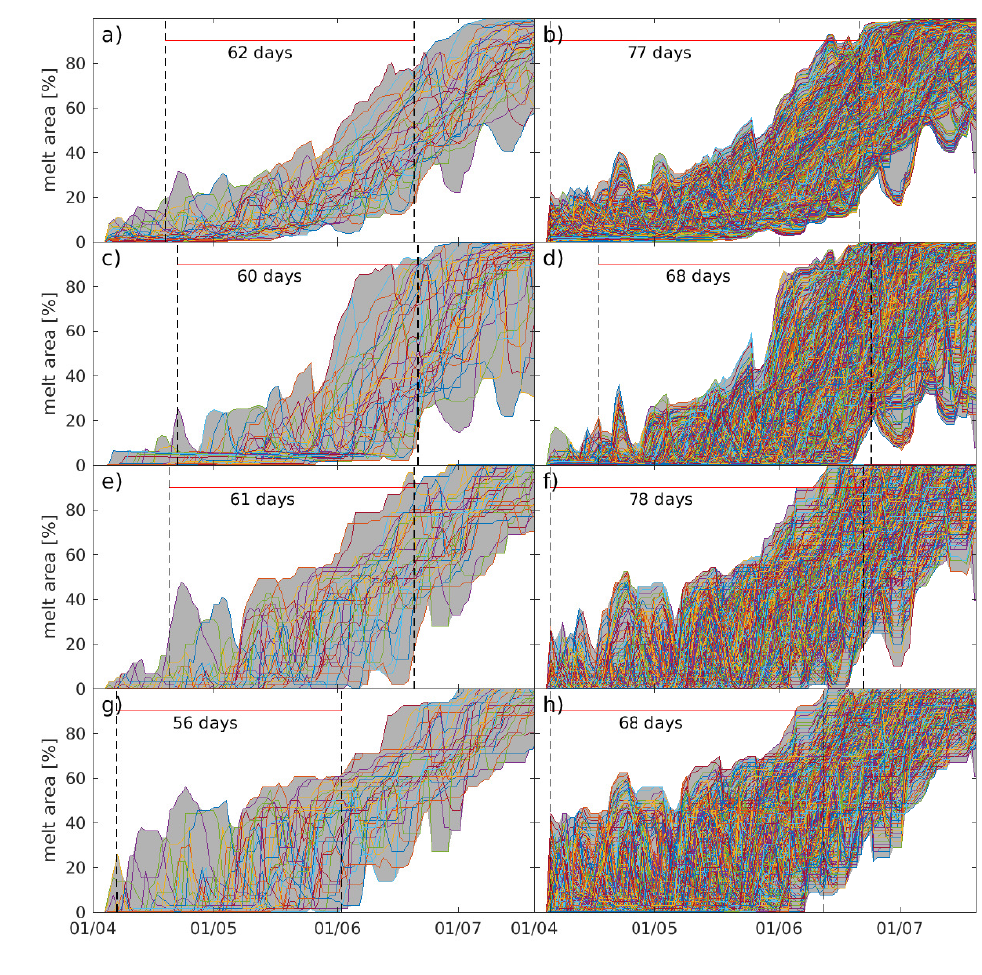
Figure 9. Time series of melt area for ( a , b ) Vatnajökull; ( c , d ) Brúarjökul; ( e , f ) Skaftá GWC; ( g , h ) Síðujökull. The four left figures show the melt area when the spring conditions are held constant, using the conditions from April 2000. The right figures show all the simulated runs. The colored lines are different summers from 1980 to 2015. The stippled lines show the earliest and latest day that 20% of the area has had an onset in